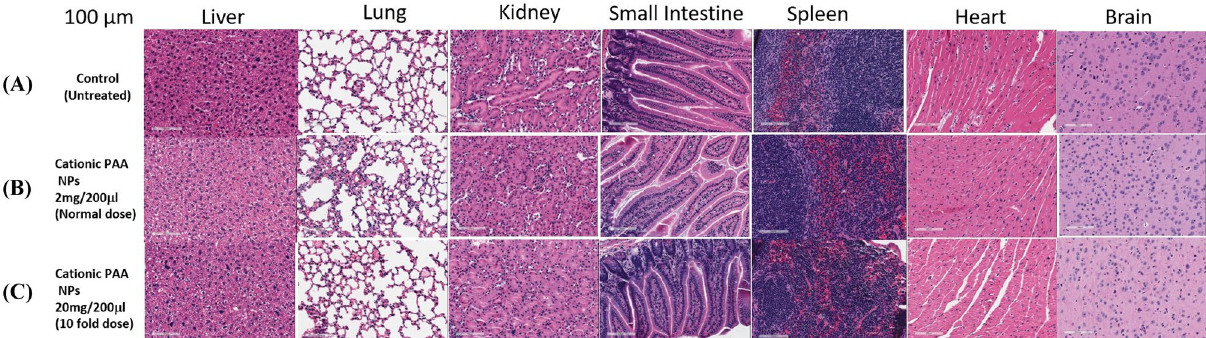
Figure 10. Representative histopathological staining of various organs (100 μm thickness) of BALB/c mice ( A ) without injecting the PAA cationic NPs to mice (control) and at day 14 post-injection of the NPs at a dose of ( B ) 2 mg/200 μλ/mouse and ( C ) 20 mg/200 μλ/mouse (tenfold higher dose of the NPs requires to inject (i. v.) a desired therapeutic dose (0.47 μmole/kg) of HPPH. No organ toxicity was observed even at tenfold higher dose of the NPs used for injecting a therapeutic dose (0.47 μmole/kg) of HPPH. The weights of mice used in this study were in the range of 20–24